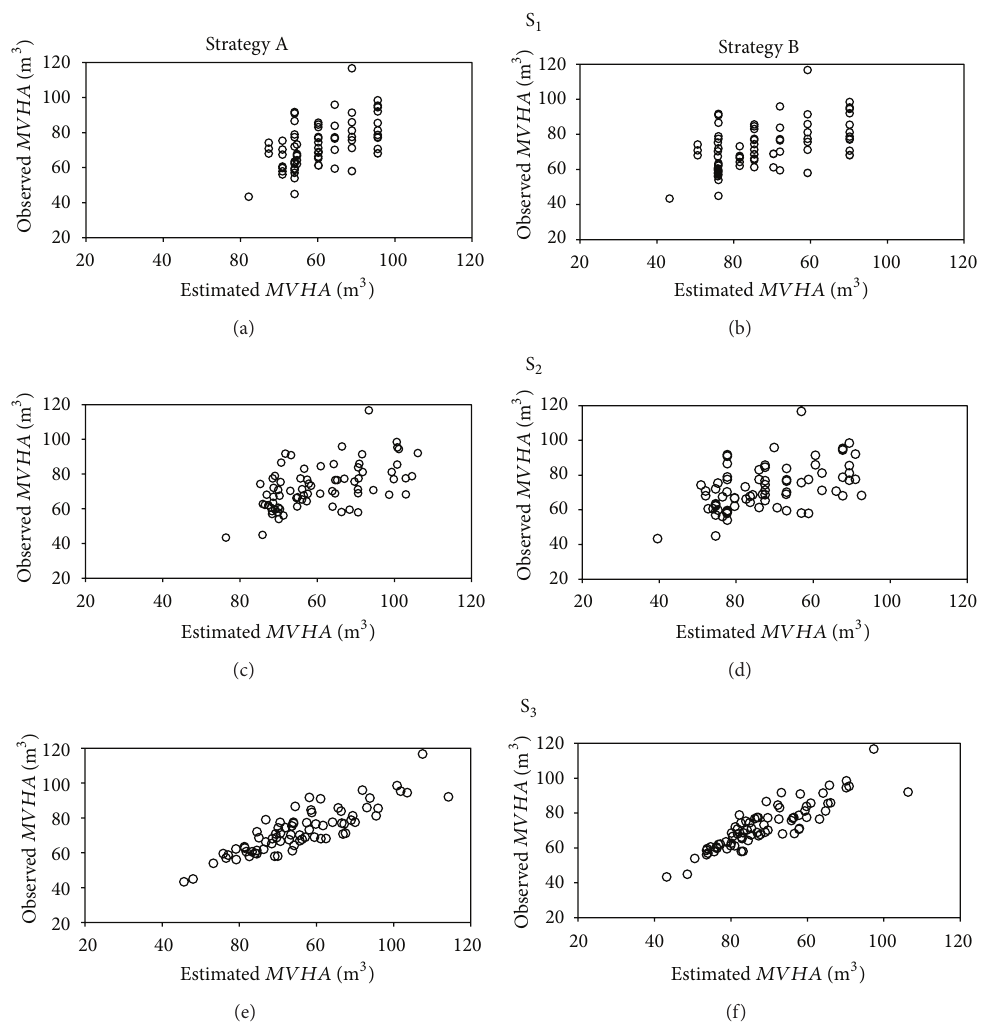
Figure 4: Scenarios for the estimates of the commercial volume at five years of age by Strategies A and